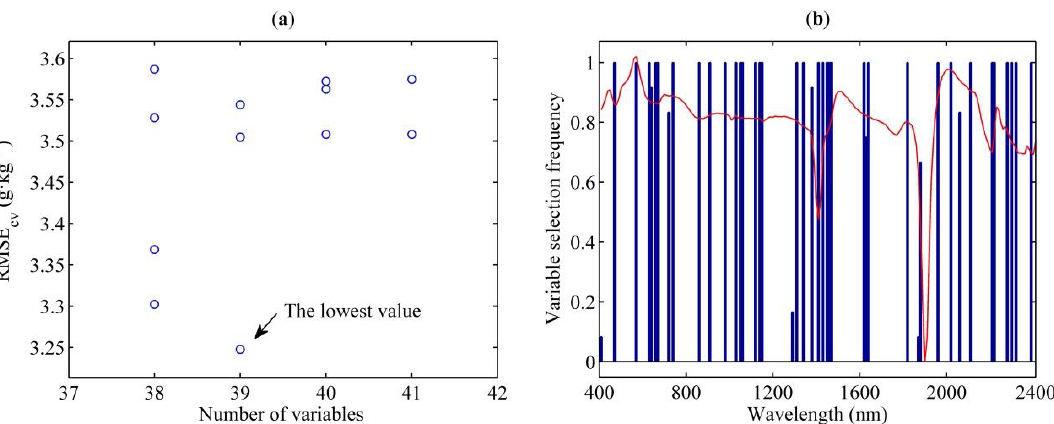
Figure 9. GA variable selection of 1-order derivative spectra: ( a ) RMSE cv values along with different number of spectral variables; ( b ) variable selection frequency.